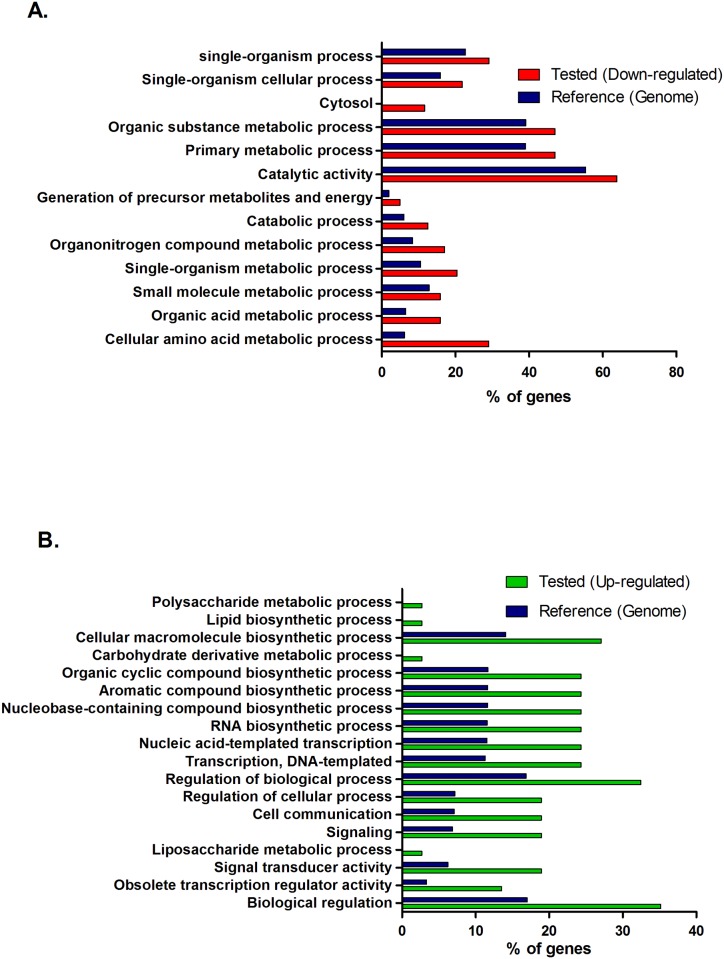
Functional enrichment of differentially expressed genes using Blast2GO software.A. Down-regulated genes. B. Up-regulated genes. P<0.05 using Fisher’s Test.